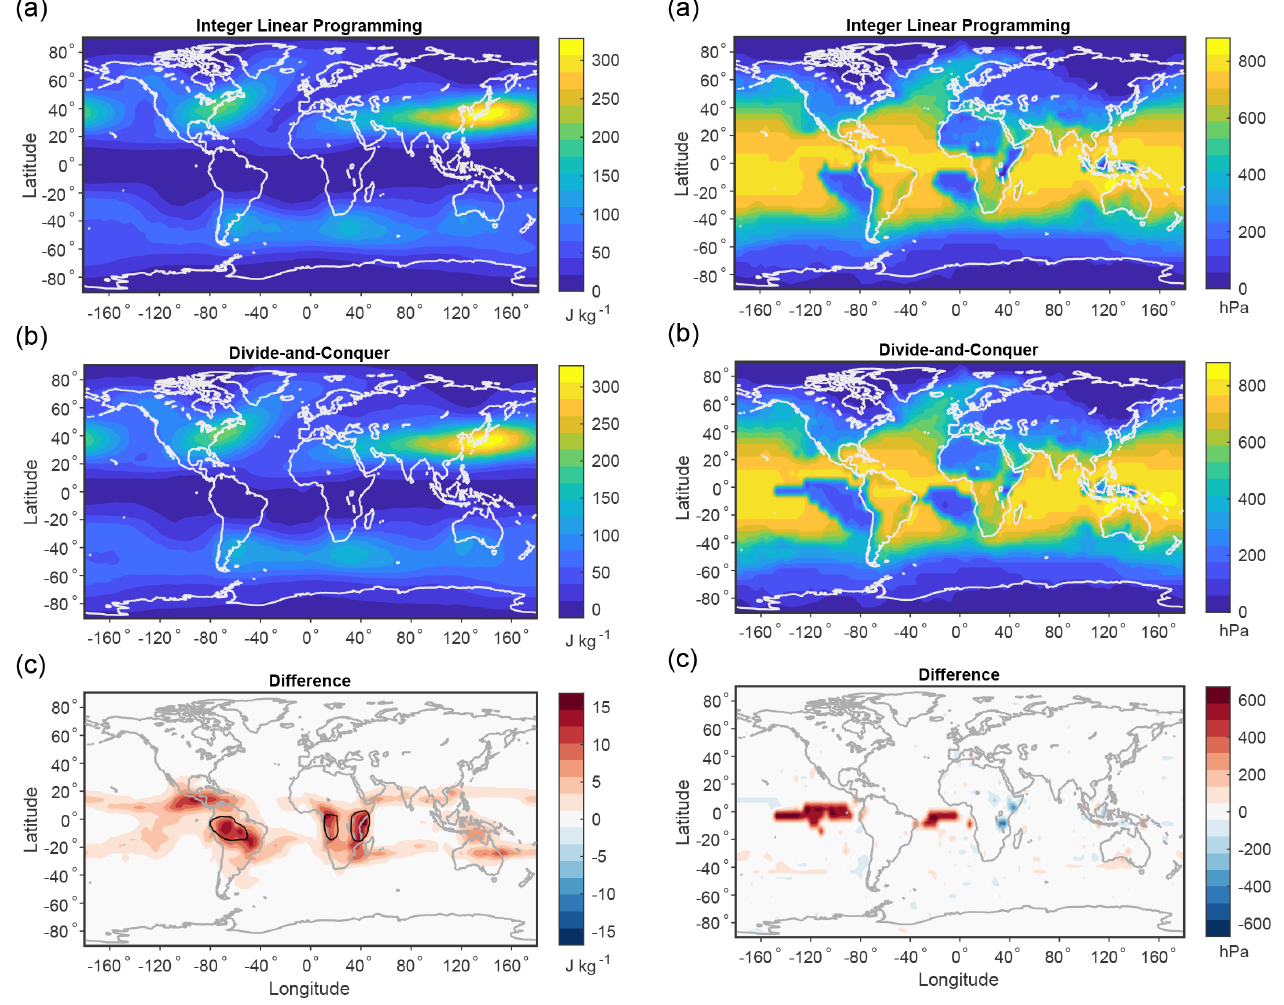
Figure B5. Sensitivity to calculation method for the local MAPE based on the DJF climatological mean over 1979–2018. Shown is MAPE calculated using (a) the exact integer linear programming approach, (b) the approximate divide-and-conquer algorithm, and (c) the difference reported as integer linear programming minus di- vide and conquer. Black contours in (c) indicate regions where the divide-and-conquer algorithm gives negative values.